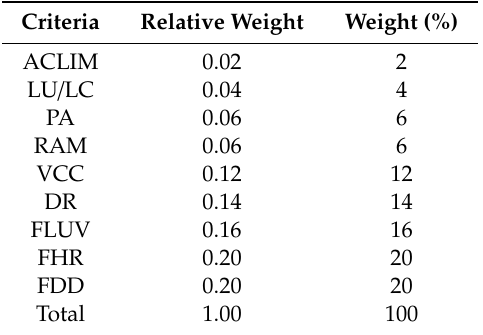
Table 12. Weights of the nine criteria of the AEZ analysis using the AHP. Criteria